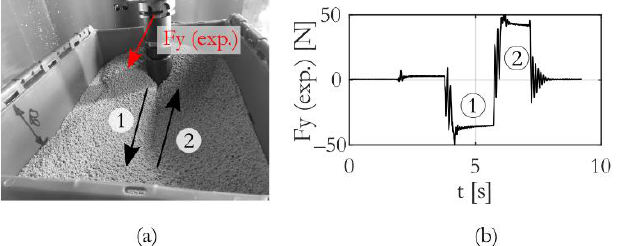
Figure 2. ( a ) The experimental setup for measuring the drag forces (Fy (exp.)) and ( b ) the resultant force signal.